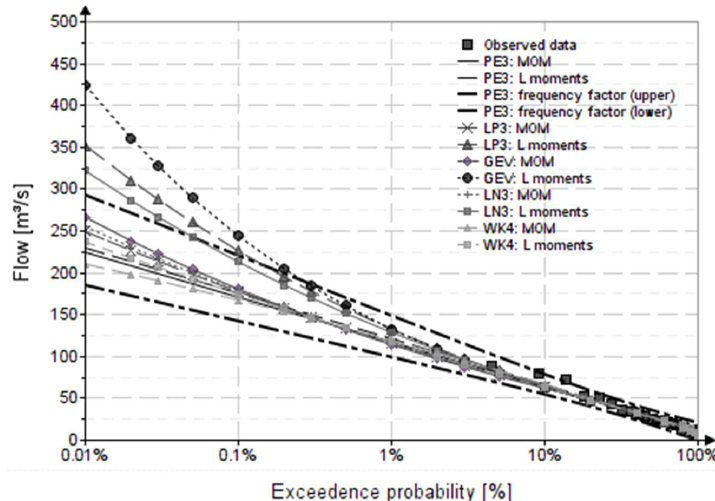
Figure 13. Comparing the frequency distributions for the Prigor river.